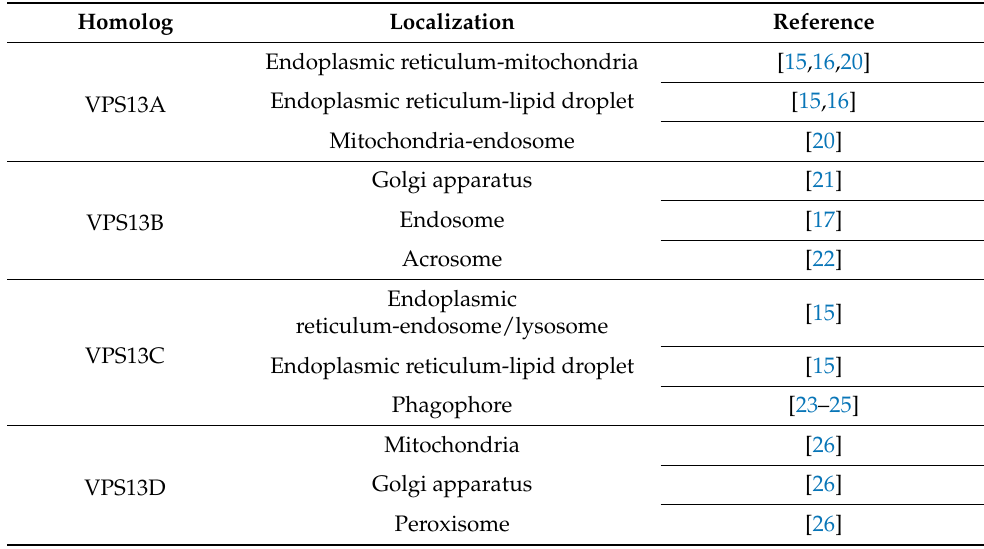
Table 1. Localization of human VPS13 proteins.